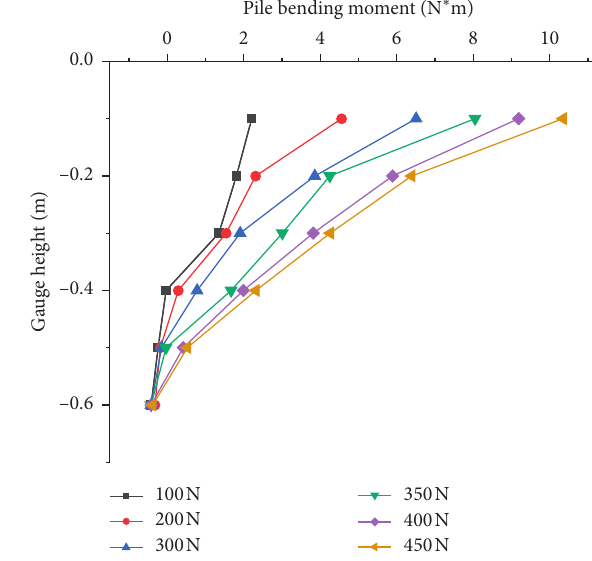
Figure 14: Curve of bending moment of the negative inclined pile loaded in y direction of two-layered soil groups with low pile